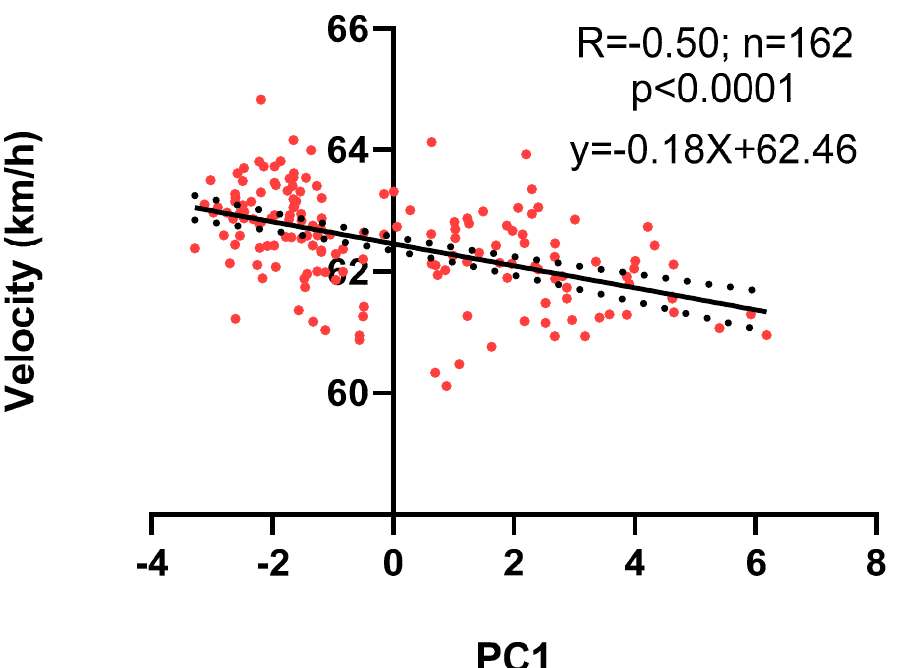
Figure 5. Running speed versus PC1. The trend line (filled) and the 95% confidence interval (dotted) are presented in black.